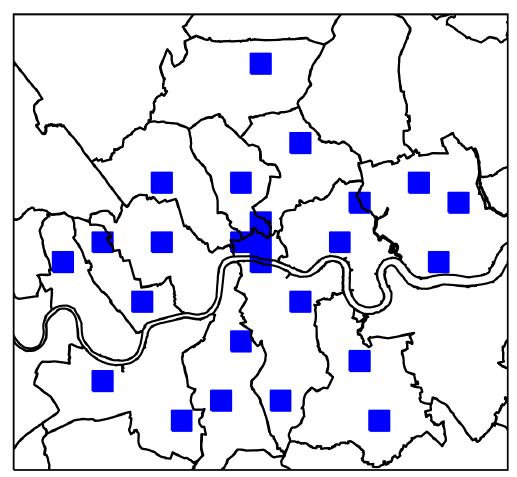
Figure 4. Map of hand-labelled areas.